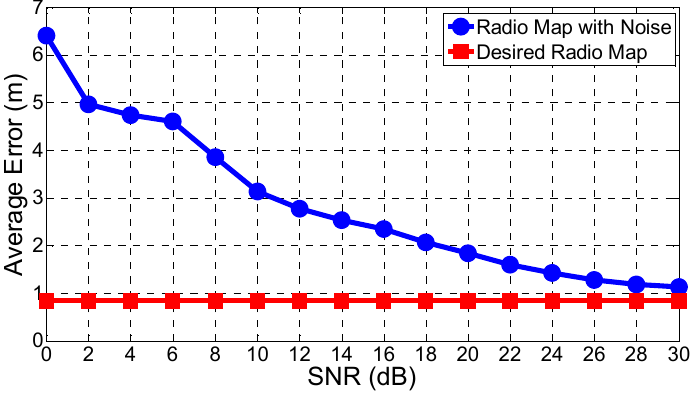
Figure 15. Localization performance affected by radio